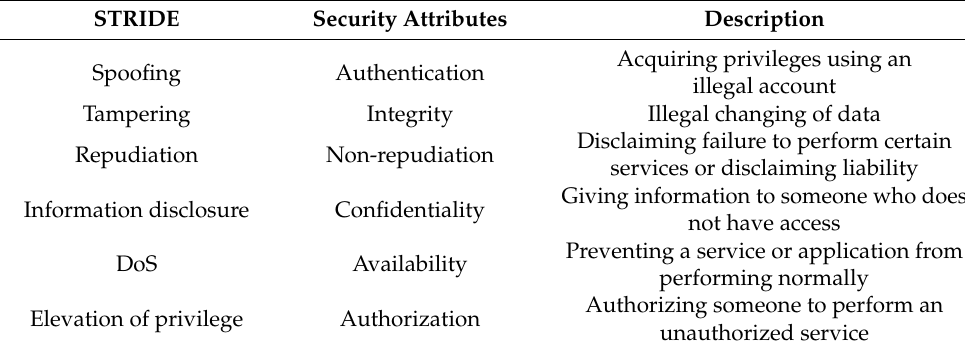
Table 6. Attributes and description of the threat modeling method